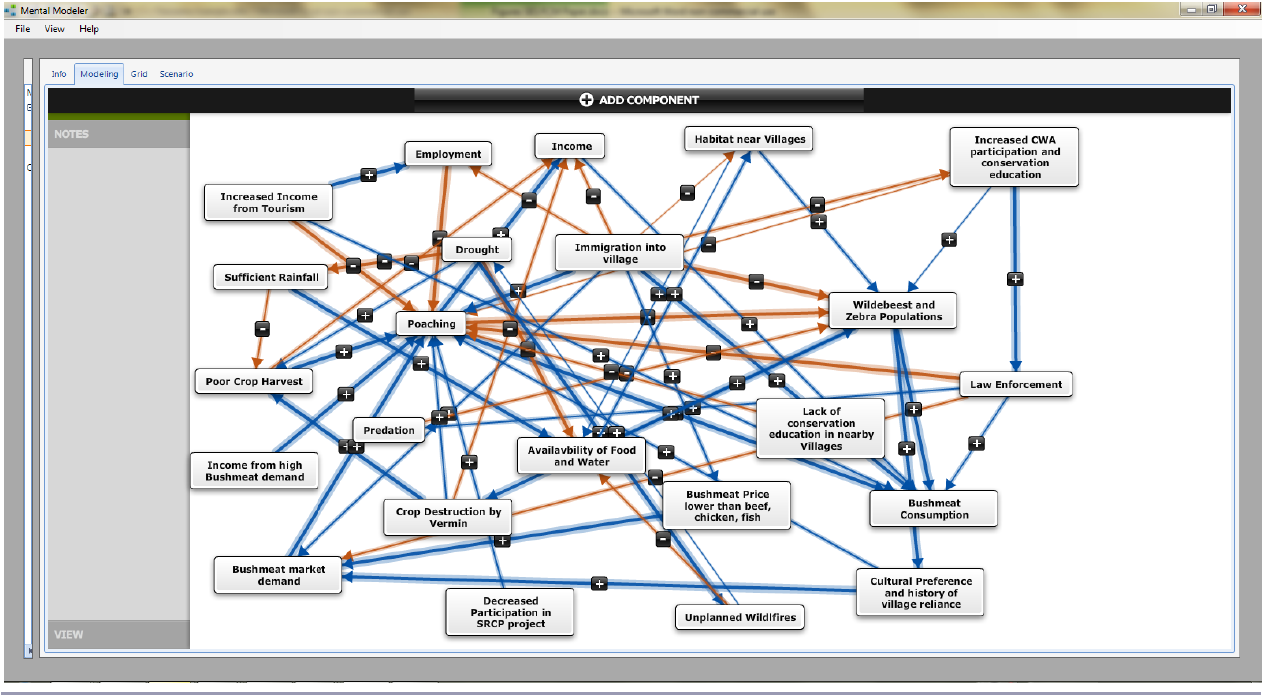
Fig. 4 . Screenshot of community model entered into fuzzy cognitive mapping (FCM) software Mental Modeler. Blue lines indicate positive relationships and orange lines represent negative relationships between components. Line thickness indicates the degree of influence between components. CWA indicates community wildlife management area; SRCP, a local microcredit lending